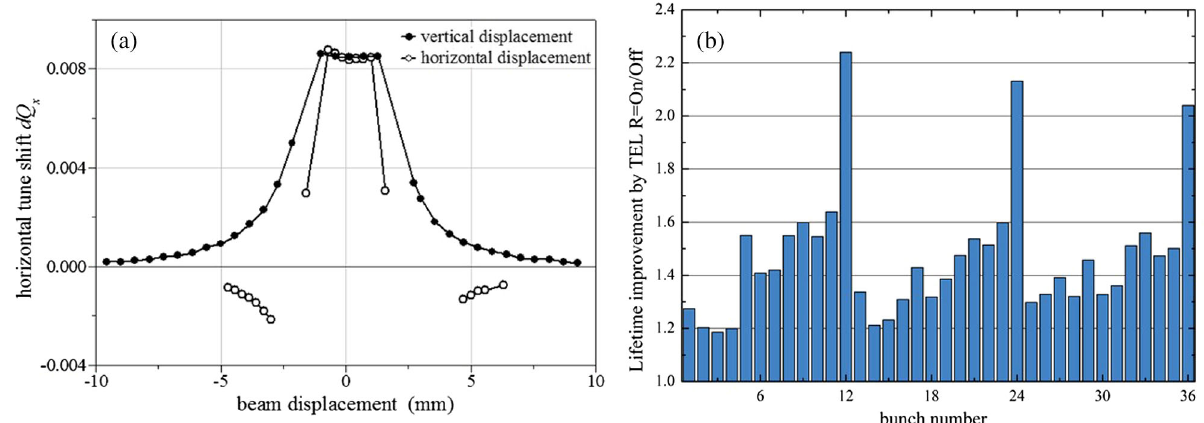
FIG. 3. (a) Left: TEL1-induced shift of a 980 GeV proton horizontal betatron tune versus vertical (filled circles) and horizontal (open circles) electron beam displacement ( J e ¼ 1 A, U c ¼ 6 . 0 kV, electron gun with uniform transverse current distribution); (b) TEL-2 in the dc regime significantly improves the lifetime of all 36 proton bunches early in the Tevatron store #5183 with initial luminosity L ¼ 253 × 10 30 cm − 2 s − 1 — from